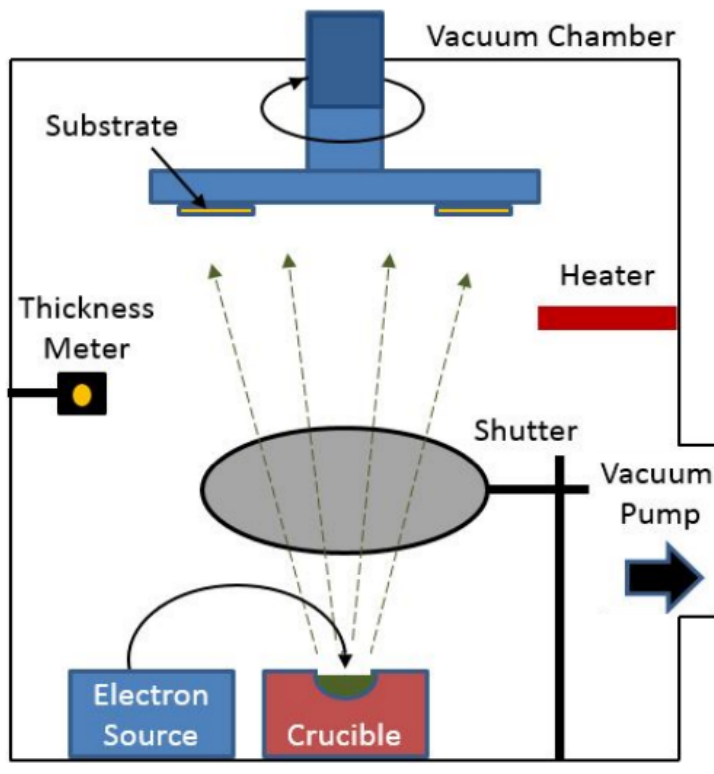
Figure 10. Simplified Electron beam evaporation system